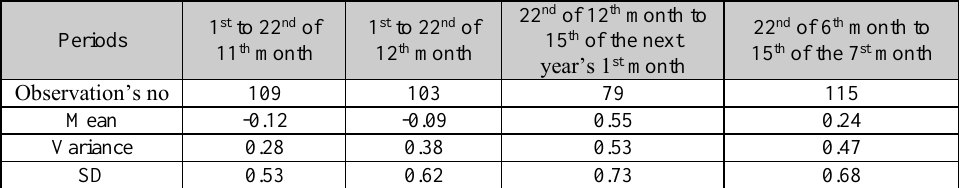
Table 1: Descriptive Analysis of data